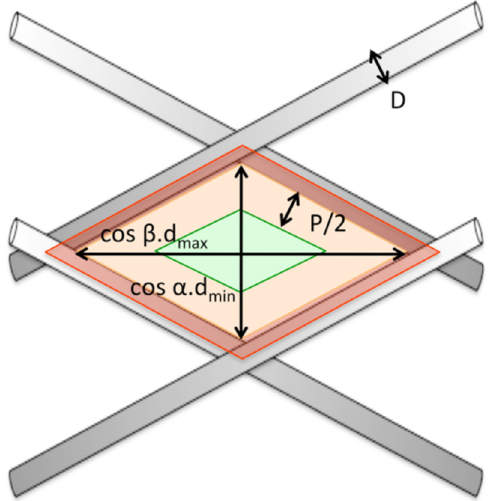
Figure A5. Geometric analysis for the rotated, diamond-shaped net/mesh armour system, taking into account the horizontal and vertical impact angles. into account the horizontal and vertical impact